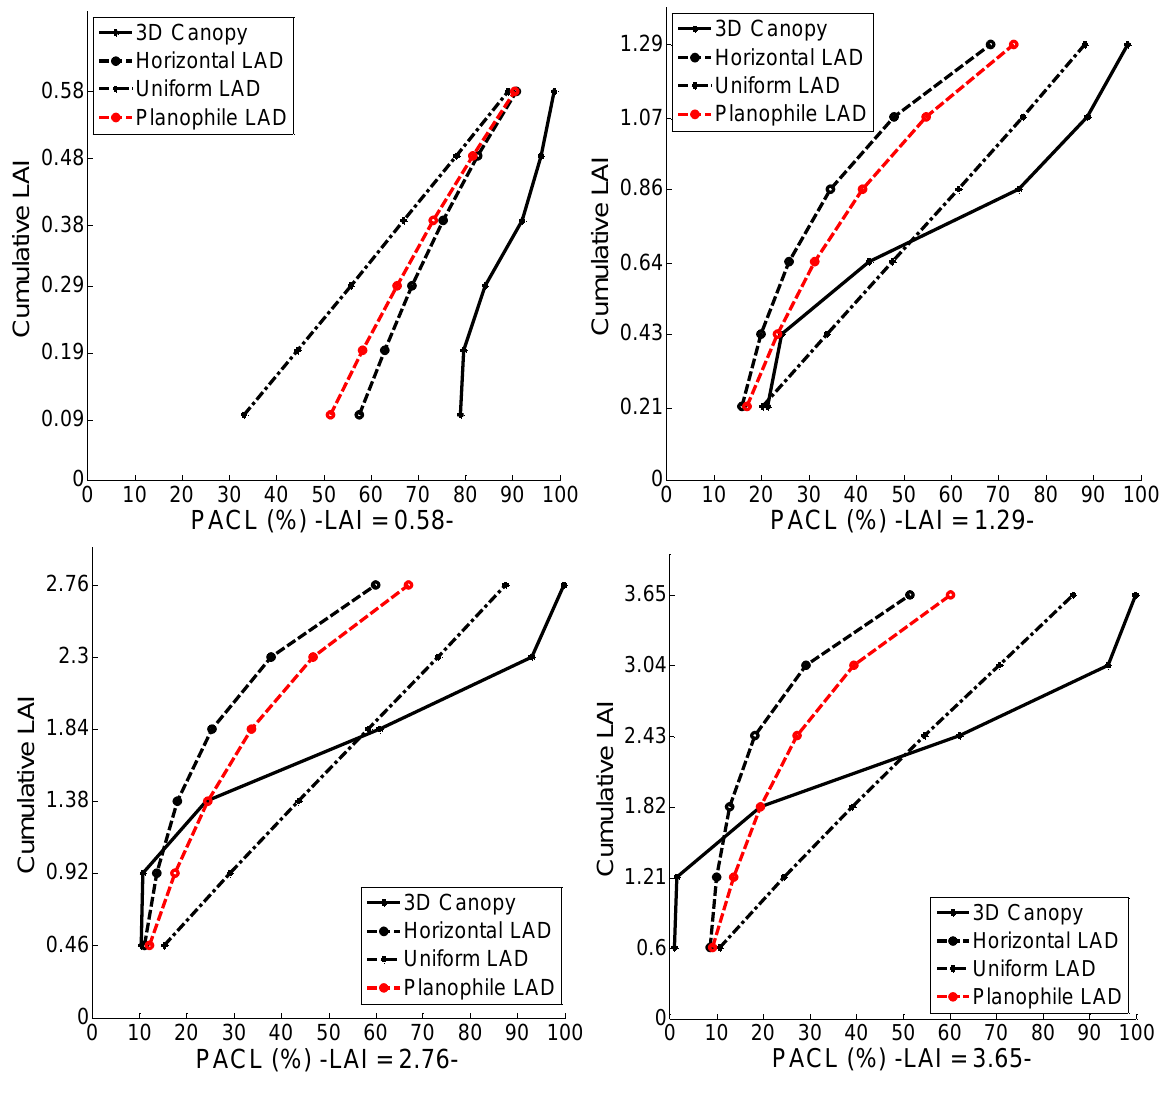
Figure 7. The PACL per cumulative LAI (increments in steps of one sixth of total LAI) is presented for the 3D architecture stands. At the same time the absorbed irradiance of the multilayer representations are depicted for the equivalent LAI